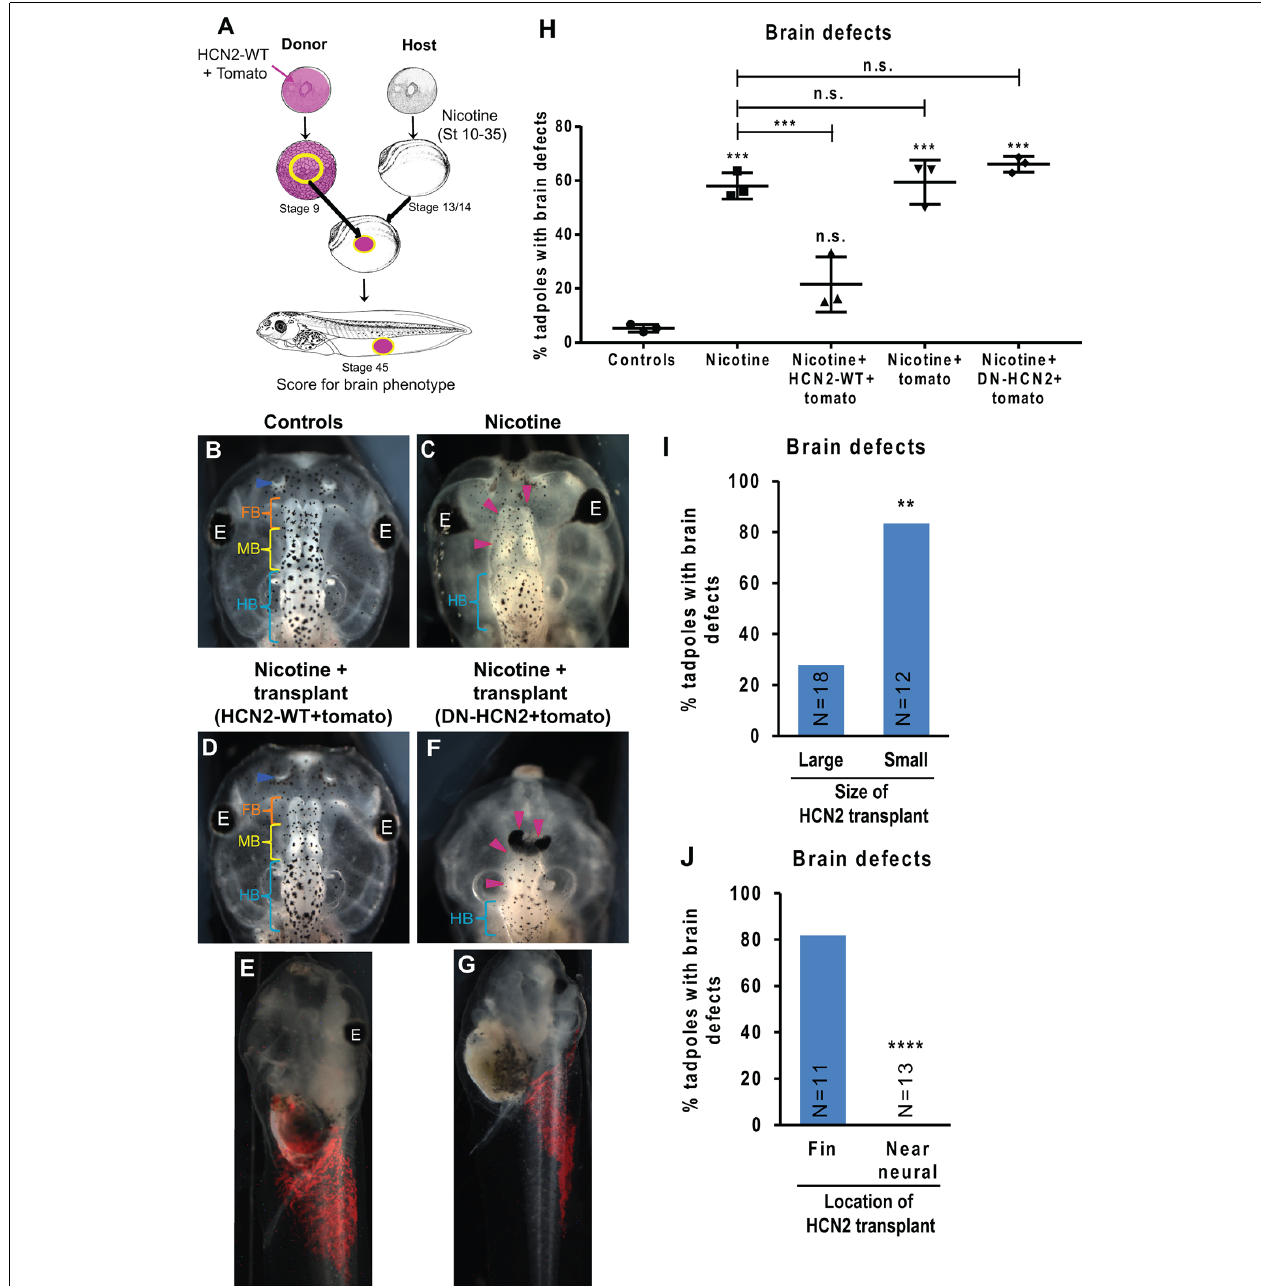
FIGURE 6 | HCN2 donor tissue can rescue brain patterning in nicotine-exposed recipient embryos over long distances. (A) Xenopus animal cap transplant experimental setup. The excised animal caps were transplanted into age-matched sibling embryos. (B–G) Representative images of stage 45 tadpoles from transplant receiving host for indicated treatment conditions. Blue arrowheads indicate intact nostrils, orange brackets indicate intact forebrain (FB), yellow brackets indicate intact midbrain (MB), cyan brackets indicate intact hindbrain (HB), and magenta arrowheads indicate severe brain morphology defects. The red region in (E) and (G) is the tomato tracer indicating the transplanted graft. (H) Quantification of stage 45 tadpole brain morphology defects under indicated conditions. Percentage of tadpoles with brain defects for each experimental group are Controls—5%, Nicotine—58%, Nicotine+HCN2-WT-tomato—22%, Nicotine+tomato—59%, and Nicotine+DN-HCN2-tomato—65%. Data are mean ± SD, *** p < 0.001, n.s.: non-significant (one-way ANOVA with Tukey’s post hoc test for n = 3 experiments with N > 20 host embryos per treatment group per experiment). (I,J) Quantification of brain morphology defects in stage 45 tadpoles exposed to nicotine and receiving Hcn2-WT+tomato mRNA expressing tissue transplant. The tadpoles were either sorted by the size of the transplant (I) or location of transplant (J) based on the tomato signal (red) at stage 45. Percentage of tadpoles with brain defects for each experimental group are: Large—27%, Small—83%, Fin—81%, and Near neural—0%. Data pooled from n = 3 independent experiments are represented as mean with χ 2 squared test for differences in proportions, **** p < 0.0001, ** p < 0.01.